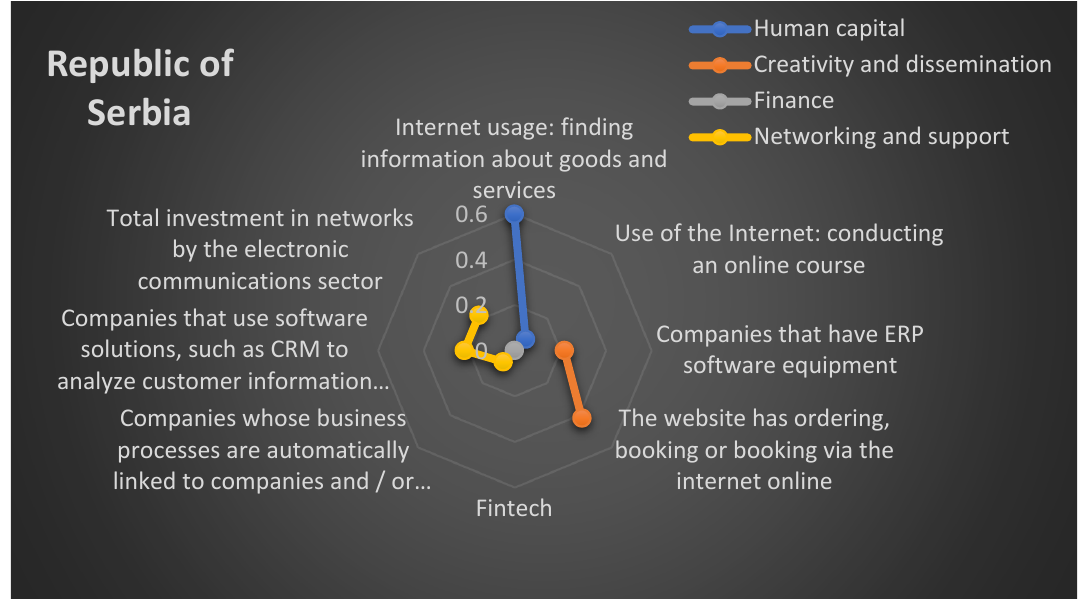
Figure 2. Values of the factors of the digital entrepreneurial system of the Republic of Serbia, in the scale-up phase of the life cycle of the enterprise, in the digital dimension.